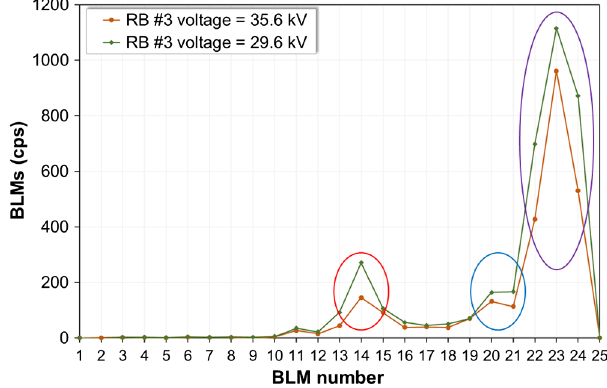
FIG. 10. BLMs count rate as a function of the voltage of rebuncher #3, 35.6 kV (orange) and 29.6 kV (green).